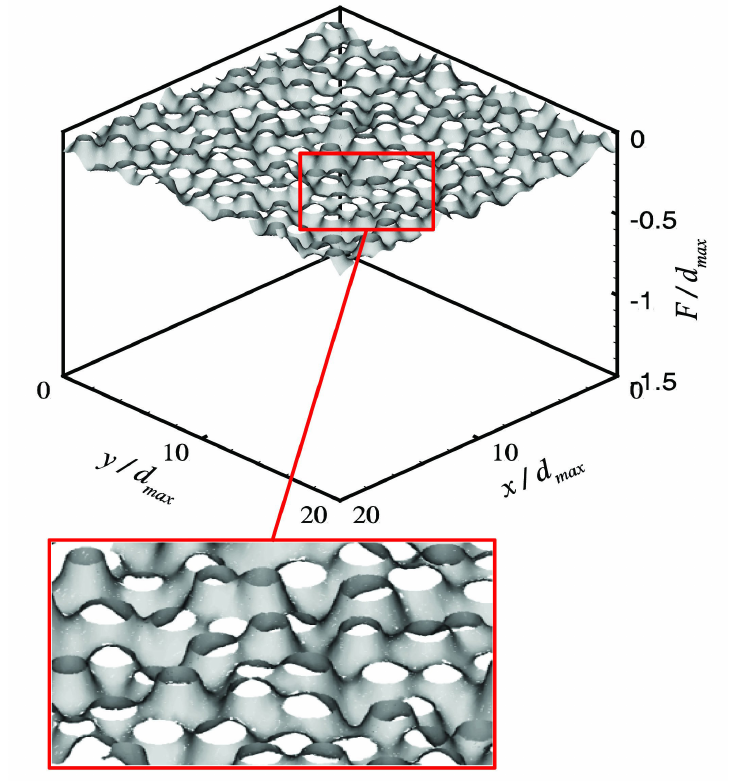
Figure 29. Calculated meniscus surfaces for superhydrophobic surface with randomly distributed posts of random diameters and heights at P = 3400 Pa. Term d maximum post’s diameter. Terms x , y , and F are Cartesian coordinates. Figure adapted from Emami et al.